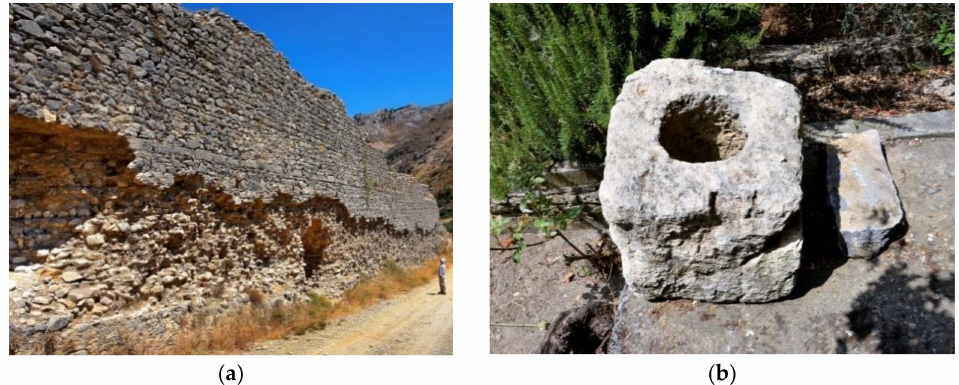
Figure 6. Remnants of Lyttos aqueduct: ( a ) of the aqueduct (known as tichos) [24] and ( b ) a stone used in the inverted siphon (photos by A. N.